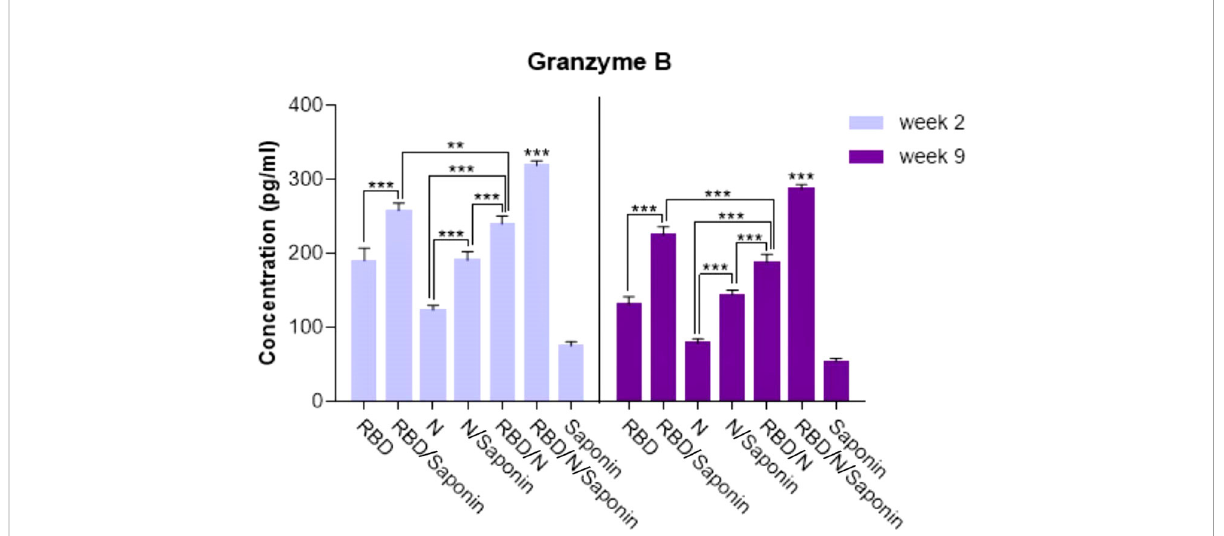
FIGURE 9 Levels of Granzyme B secreted by splenocytes in immunized mice. The supernatants of splenocytes re-stimulated with RBD/N speci fi c epitope, collected two and nine weeks after the last immunization. ELISA method was performed to determine the level of Granzyme B in splenocyte cultures. Results are representative of three independent experiments and are expressed as the mean ± SD. The RBD/N adjuvanted with Saponin induced strong levels of Granzyme B when compared to the other groups. **P < 0.01; ***P <